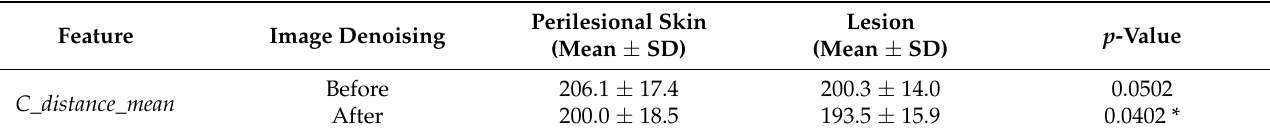
Table 2. The p -values and mean ± SD of the significant features used to identify lesions in the denoising images. Feature